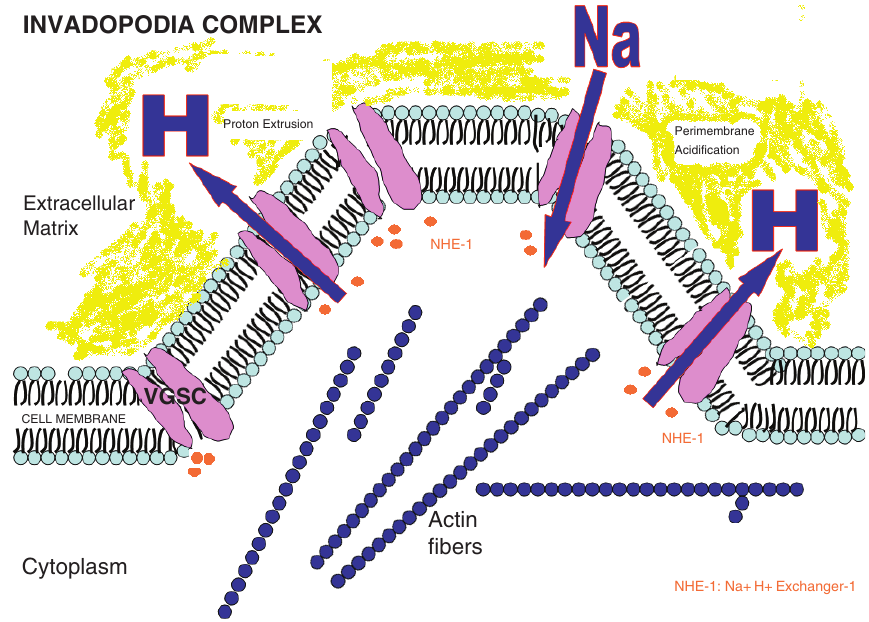
Figure 4. Proton extrusion through VGSC and NHE-1 (sodium hydrogen exchanger-1) produces acidification of extracellular matrix surrounding the cellular membrane (yellow area in the figure). (Brisson 2013 39 ; Gillet 2009 40 ). Acidification activates cathepsine degradation of the extracellular